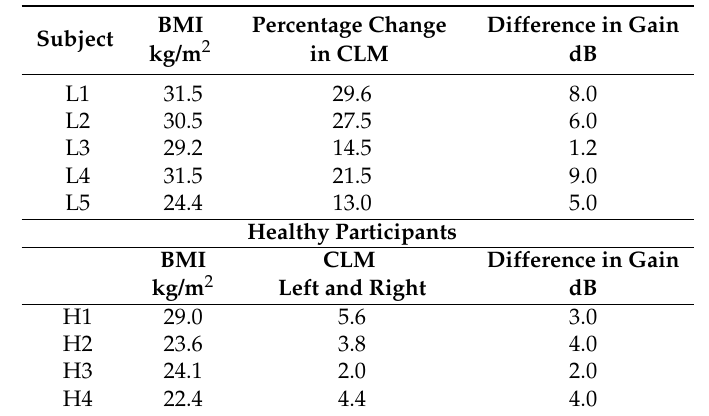
Table 3. Comparison of CLM and the average difference in galvanic signal amplitude between the affected and unaffected lower limbs.